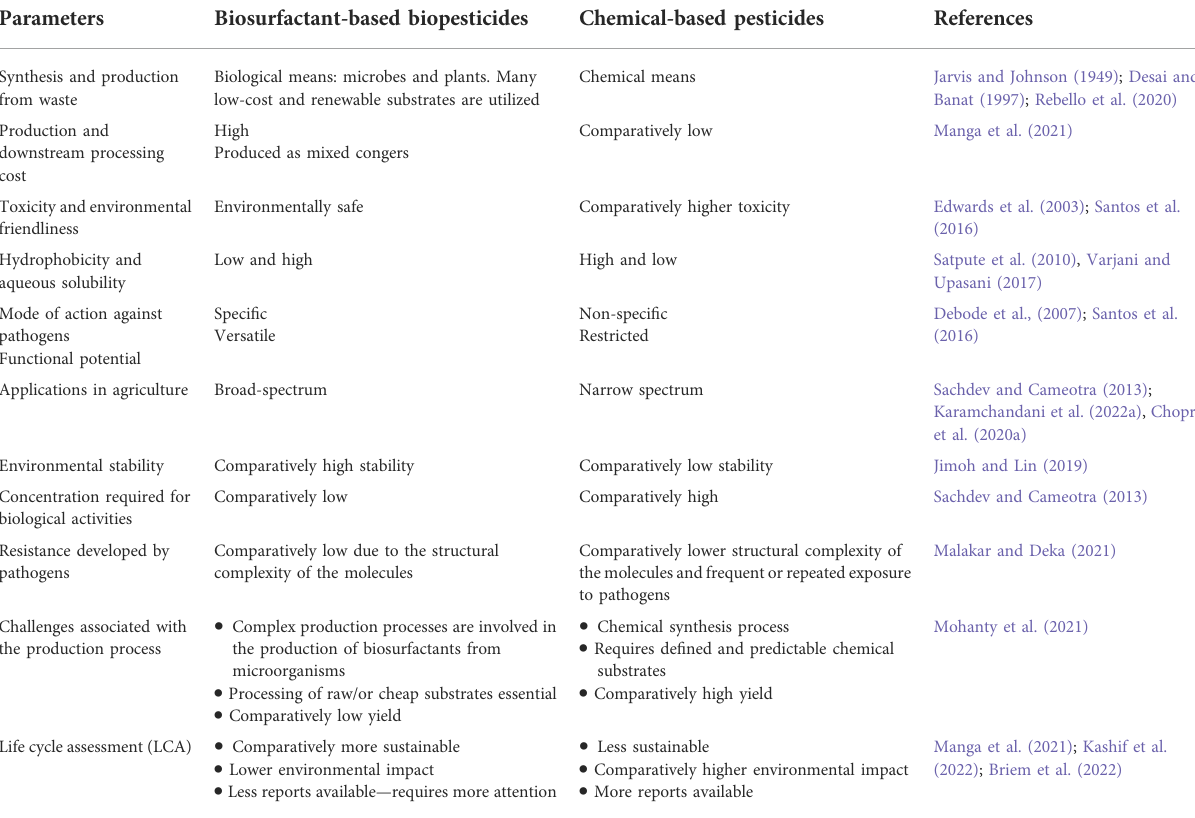
TABLE 2 Comparison between biosurfactant-based biopesticides and chemical-based